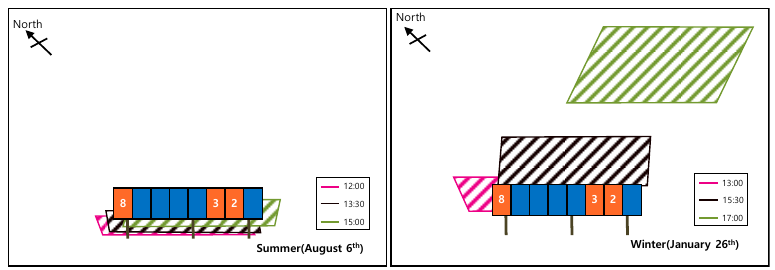
Figure 9. Shadow locus for summer season ( left ) and winter season ( right ).